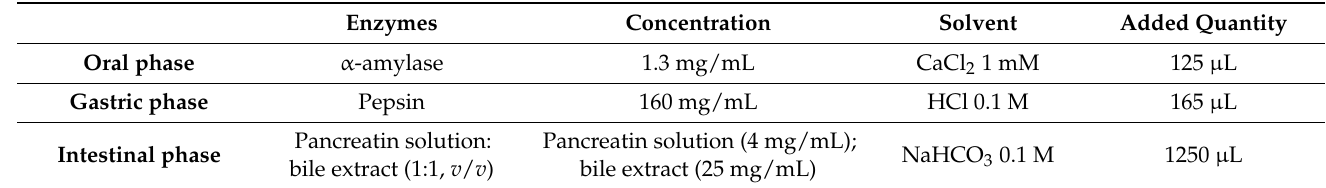
Table 1. Composition of the simulating digestive